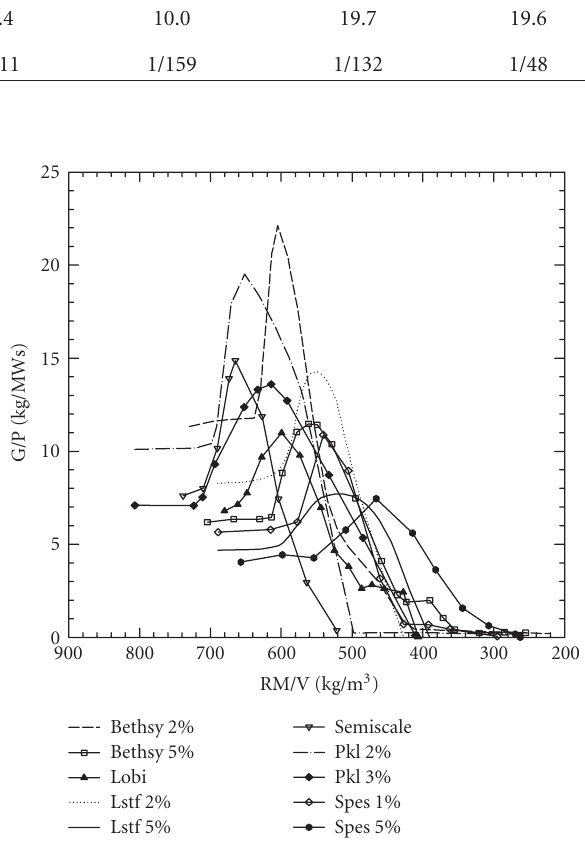
Figure 2: Natural circulation system behaviour measured in ten experiments performed in six PWR